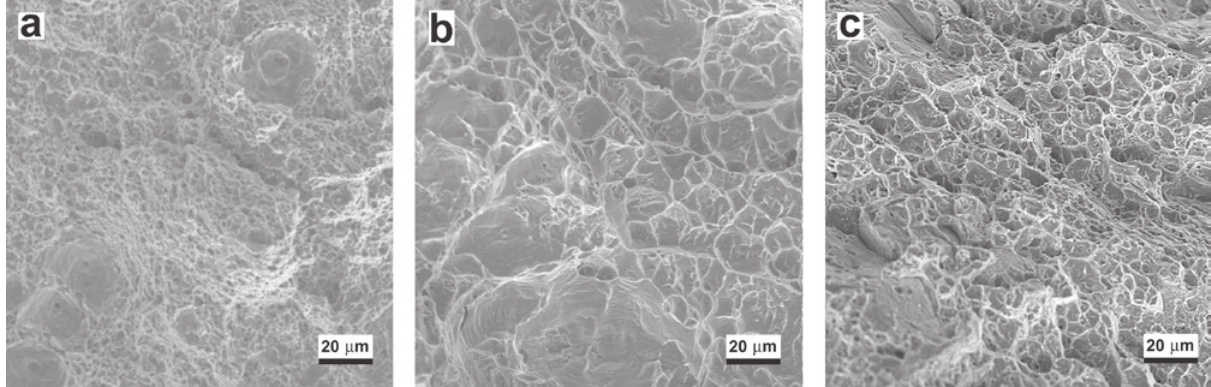
Fig. 6: SEM-fractographs of different regions of the welded joint T91/TP316H in PWHT state after the room-temperature tensile testing in condition with hydrogen charging: T91 steel HAZ (a), Ni WM Thermanit Nicro 82 (b), TP316H steel HAZ (c).